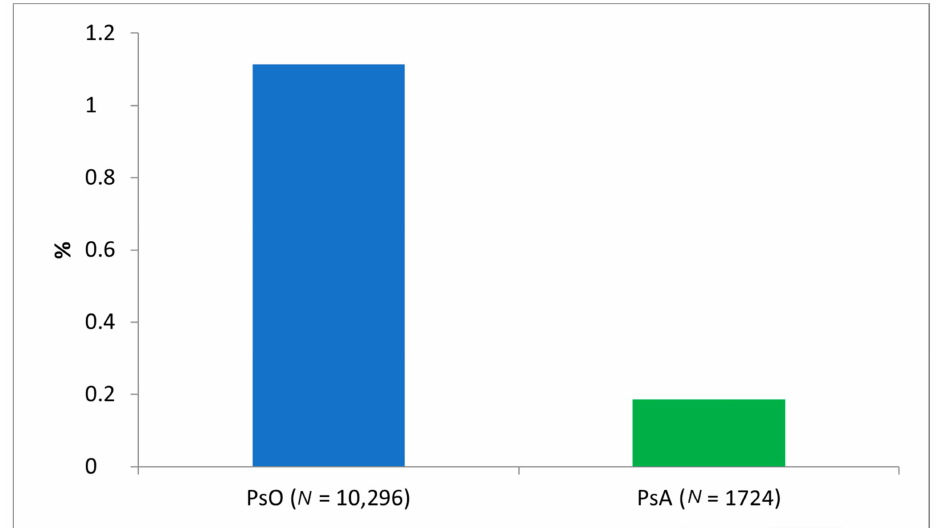
Figure 1. Prevalence (%) of patients with psoriasis and psoriatic arthritis in Caserta Local Health Unit in the years 2010–2018. Legend: Pso, psoriasis; PsA, psoriatic arthritis. During the period 2016–2018, more than half of the psoriatic patients ( N = 5301; 51.6%) were untreated, compared to 251 (15%) of the PsA patients (Figure 2).